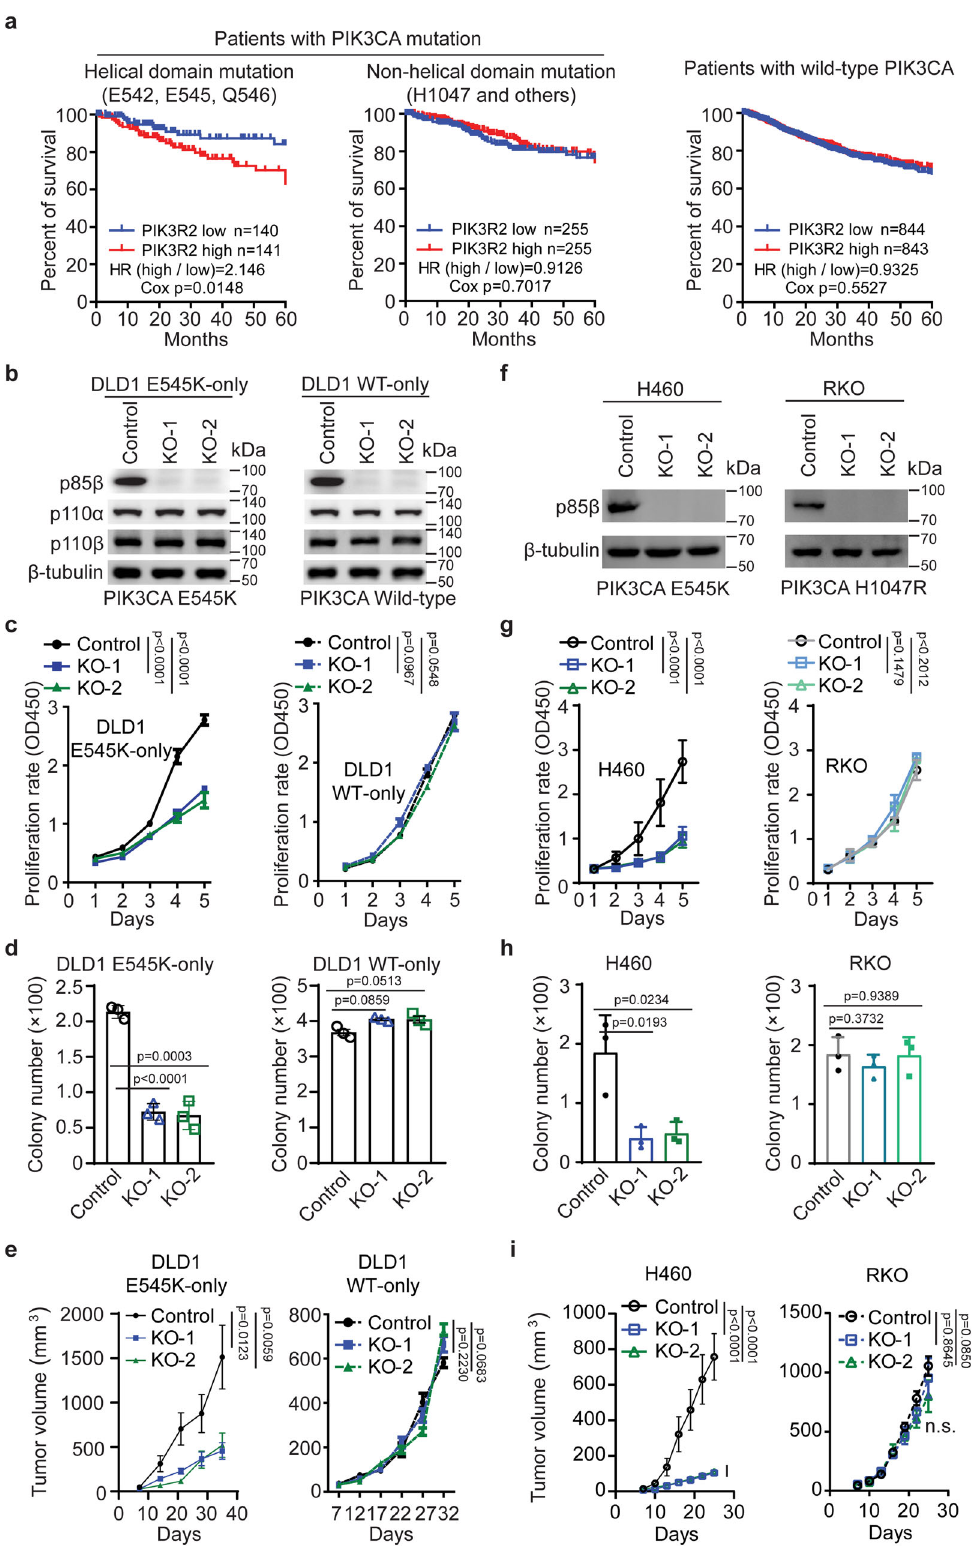
H1047R mutation (Fig. S3g). Last, live-cell imaging also showed that p85 β -mCherry initially co-localized with p110 α E545K-GFP (yellow color), then dissociated from the mutant p110 E545K- GFP and translocated into the nucleus (supplementary video 1, Fig. S3h), whereas p85 β -mCherry did not dissociate from WT